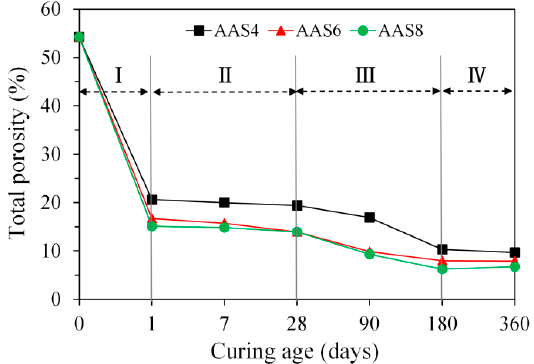
Figure 7. The total porosity of samples as a function of time up to 360 days, derived from MIP. In the graphs, I, II, III, and IV represent four stages, AAS indicates alkali-activated slag, and the number following AAS refers to the weight percentage of Na 2 O with respect to slag. For all samples, the water to slag ratio was 0.4 and the curing temperature was 20 °C.